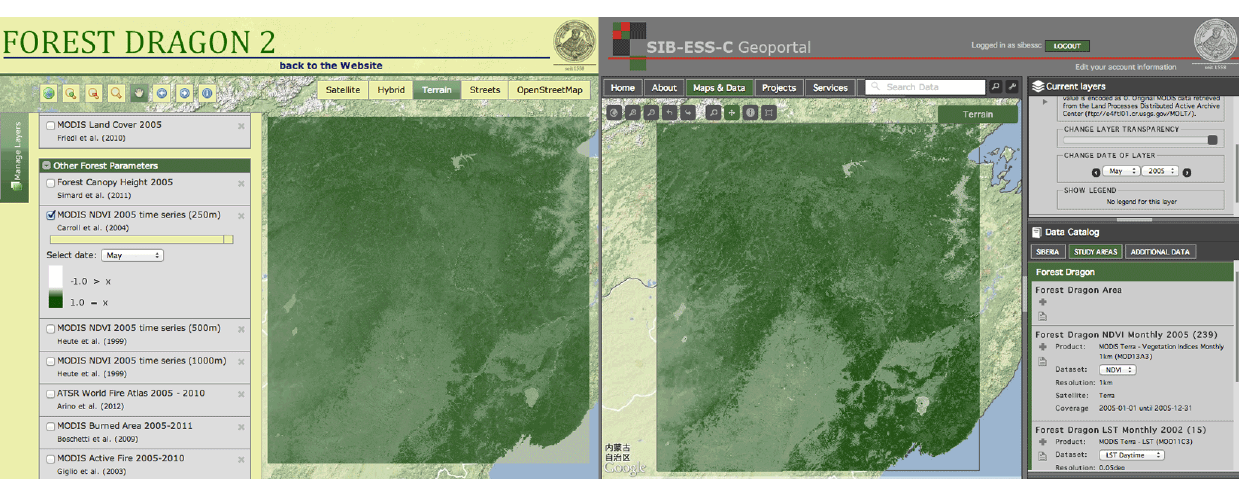
Figure 11. Forest Dragon 2 Geoportal ( Left ) shows the processed datasets from the SIB-ESS-C ( Right